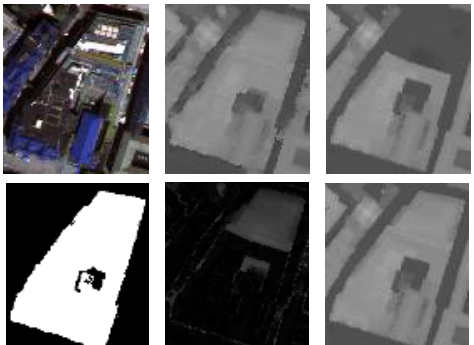
Figure 6.Top: Lidar DSM (right), Worldview-2 DSM (Middle), RGB image (left), Bottom: updated DSM (right), the absolute difference between two DSMs (Middle), the sum of two DSMs (left)